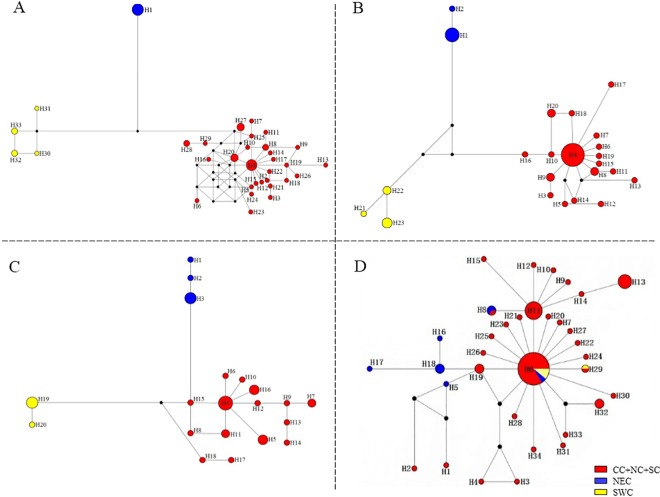
Median-joining (MJ) networks of G. birmanica haplotypes based on analysis of the following genes (A) COI; (B) COII; (C) Cytb and (D) ITS2 region. The sizes of circles are proportional to the number of individuals in the data point. Abbreviations: CC-NC-SC (central-northern-southern China); NEC, northeastern China (NEC), and SWC, southwestern China.